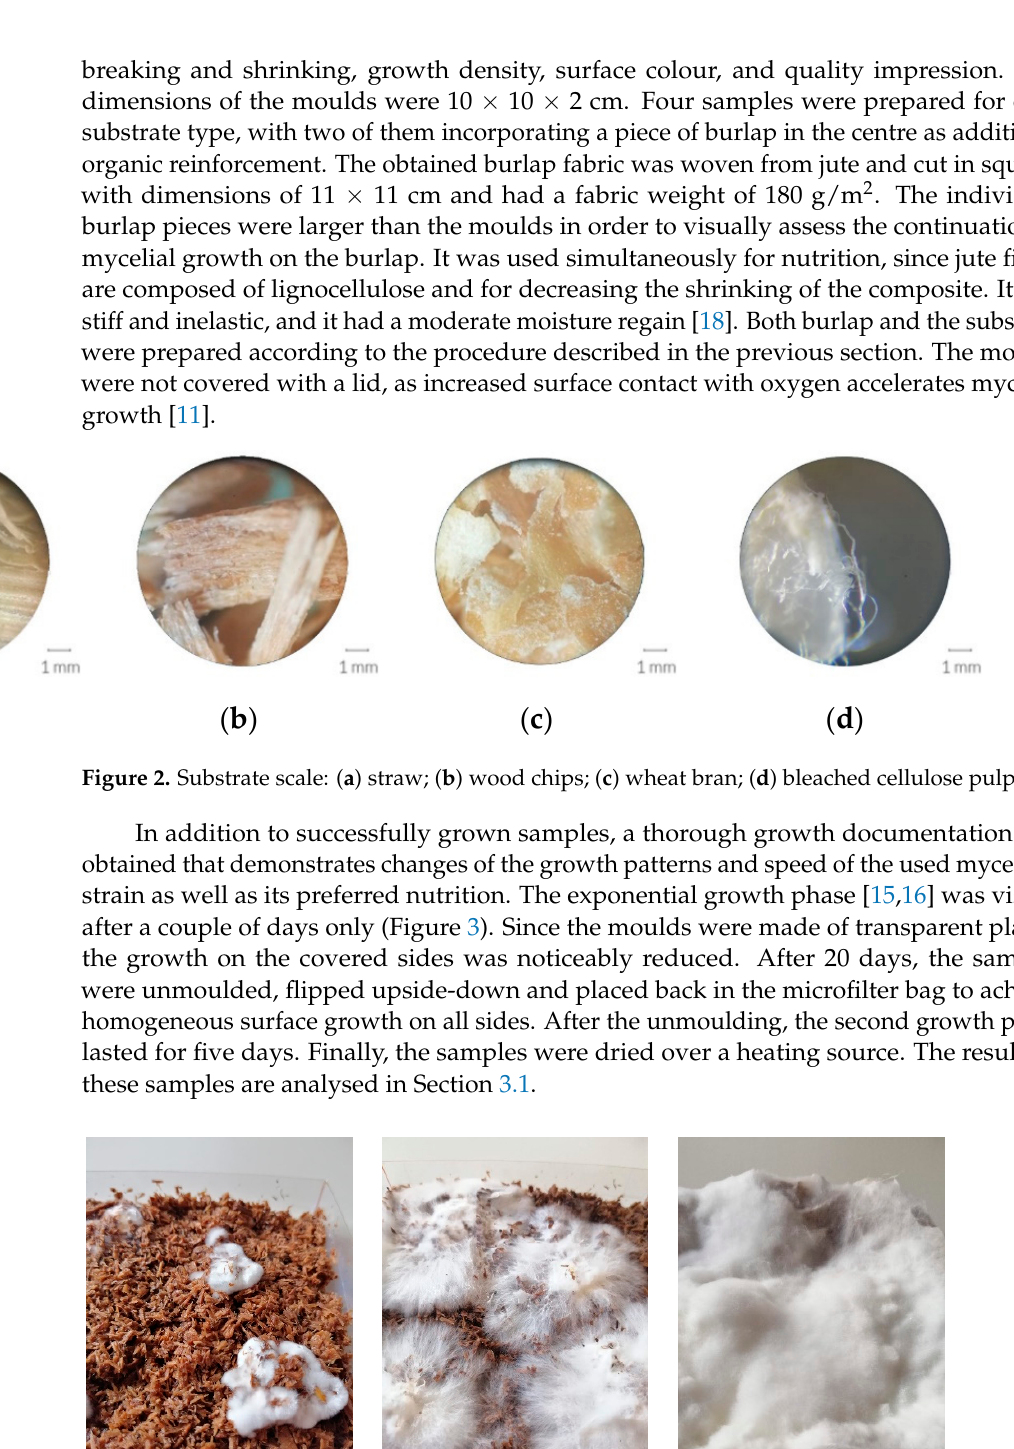
Figure 3. Close-up of the growth process of oyster mushroom mycelium on beech sawdust: ( a ) after three days; ( b ) after five days; ( c ) after 19 days.